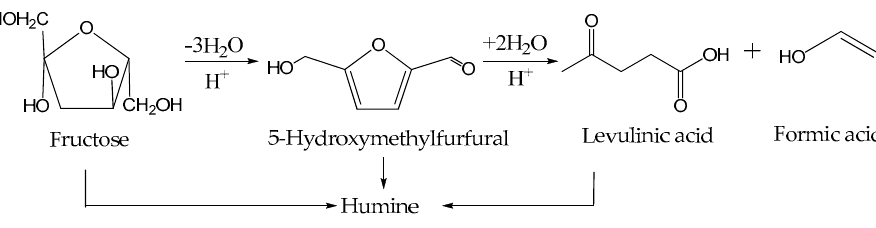
Figure 3. Concentration–strength acid site distribution for ZrO 2 –SiO 2 and ZrO 2 –SiO 2 –SnO 2 samples.